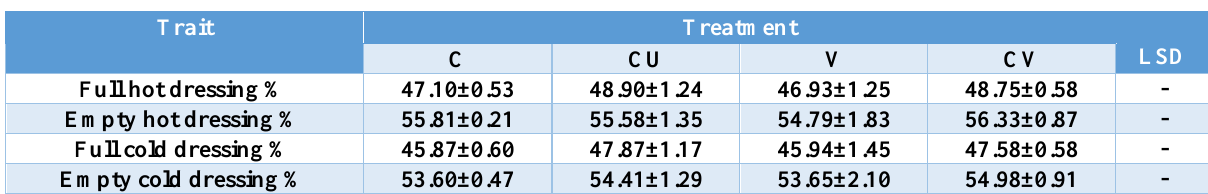
Table, 2: Effects of vasectomy and/or adding Cuminum cyminum in the diet on dressing percentages % of Awassi male lambs (Means ± SE)